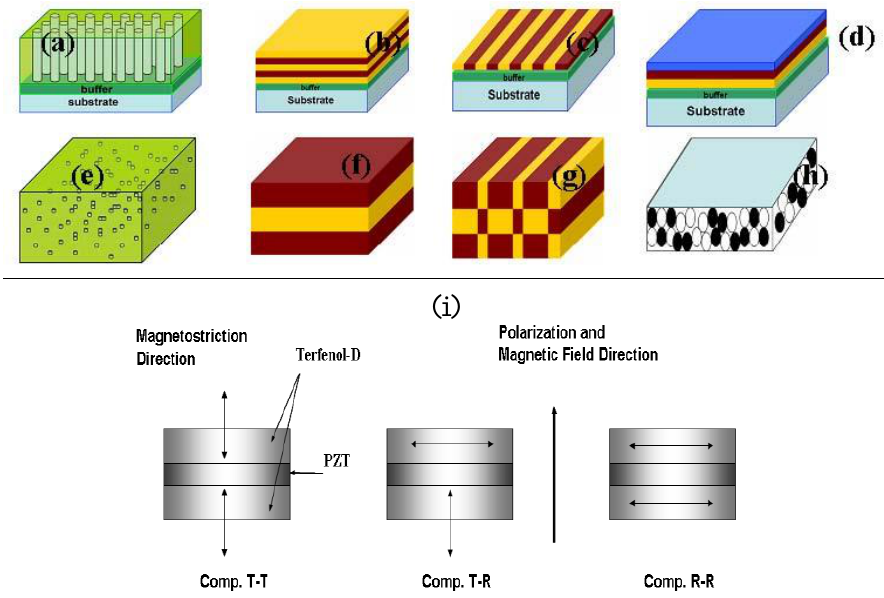
Figure 1. Schematics of the magnetoelectric composites illustrating the multiple possibilities (a) self-assembled nano-pillar structures; (b) layer by layer deposition; (c) deposition accompanied by masking and patterning; (d) three phase deposition for gradient materials; (e) particles dispersed in a polymer matrix; (f) lamination; (g) checkerboard arrangement; (h) sintered particulates; and (i) variation in poling, applied field direction and measuring